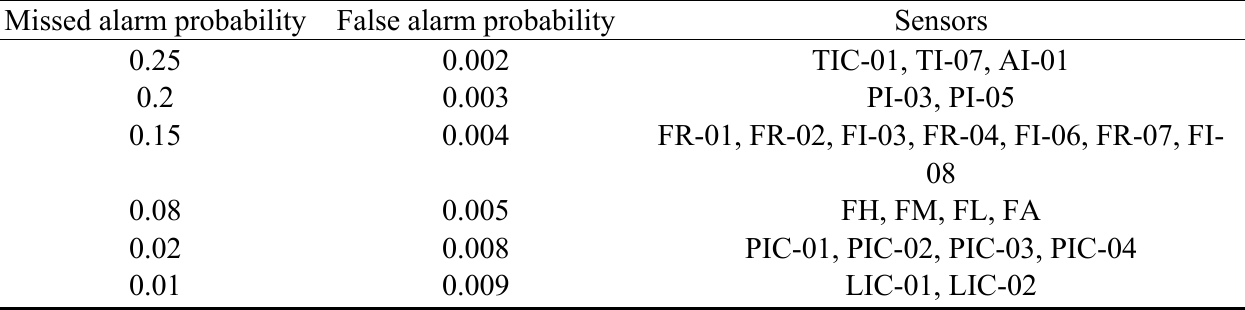
Table 2. Sensor missed alarm probabilities and false alarm